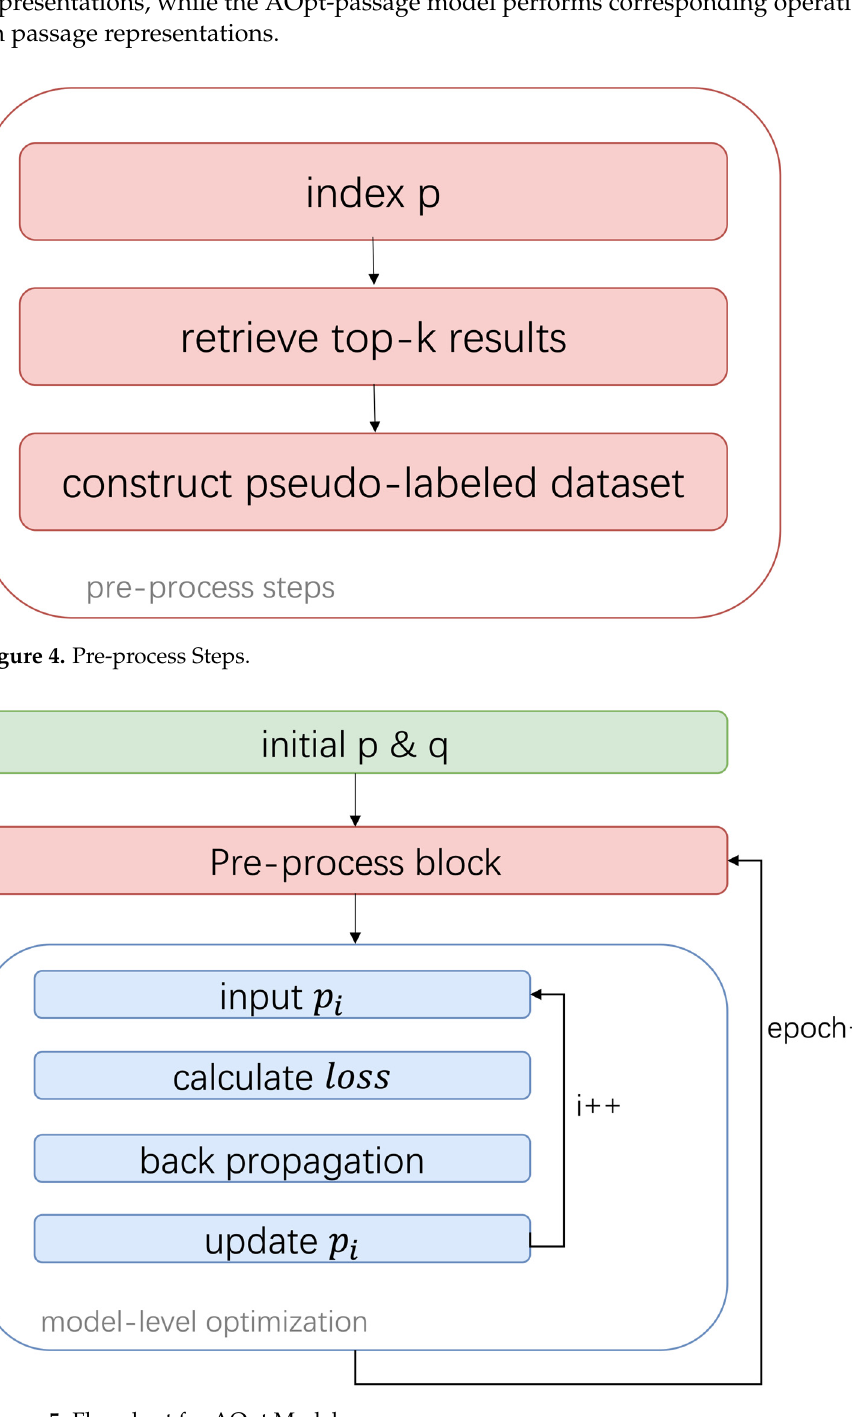
Figure 5. Flowchart for AOpt Model.